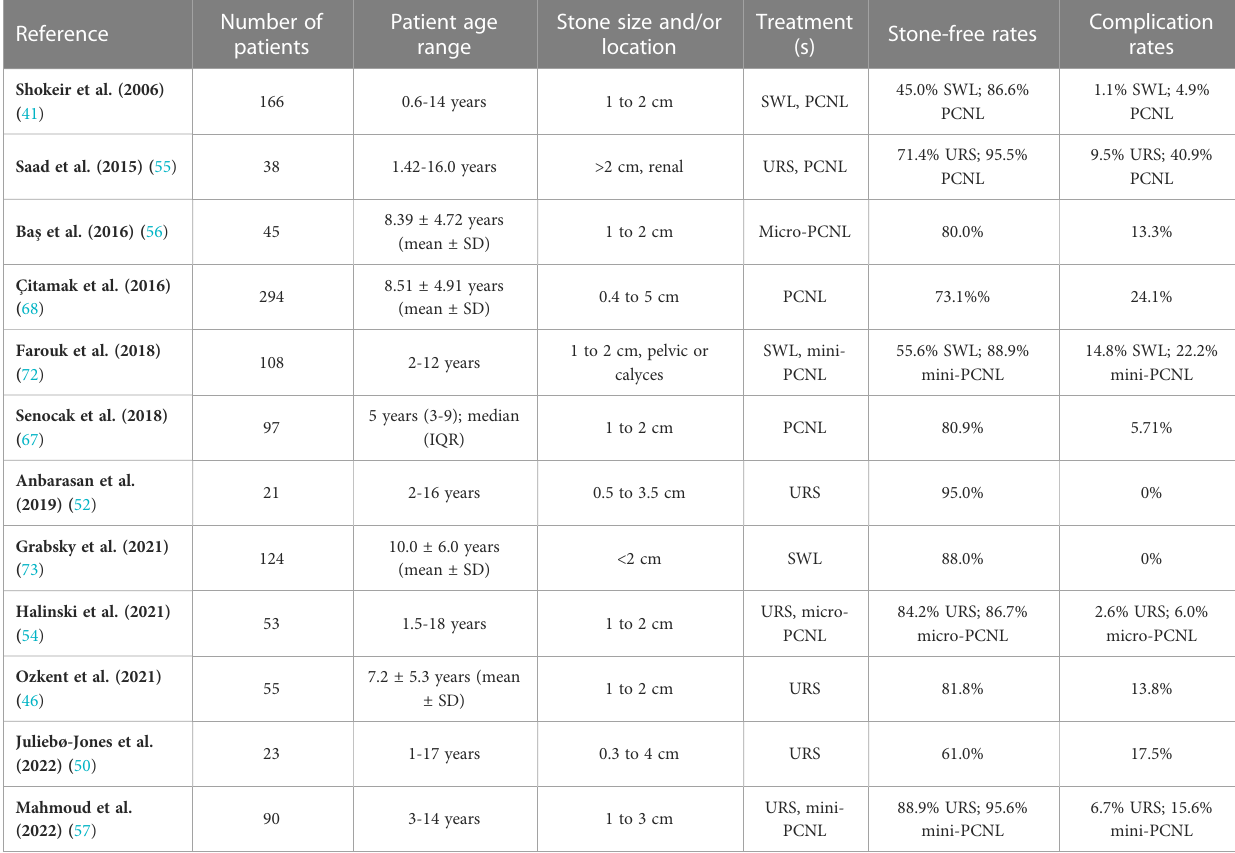
TABLE 2 Summary of outcomes of various endourologic treatments for pediatric stone